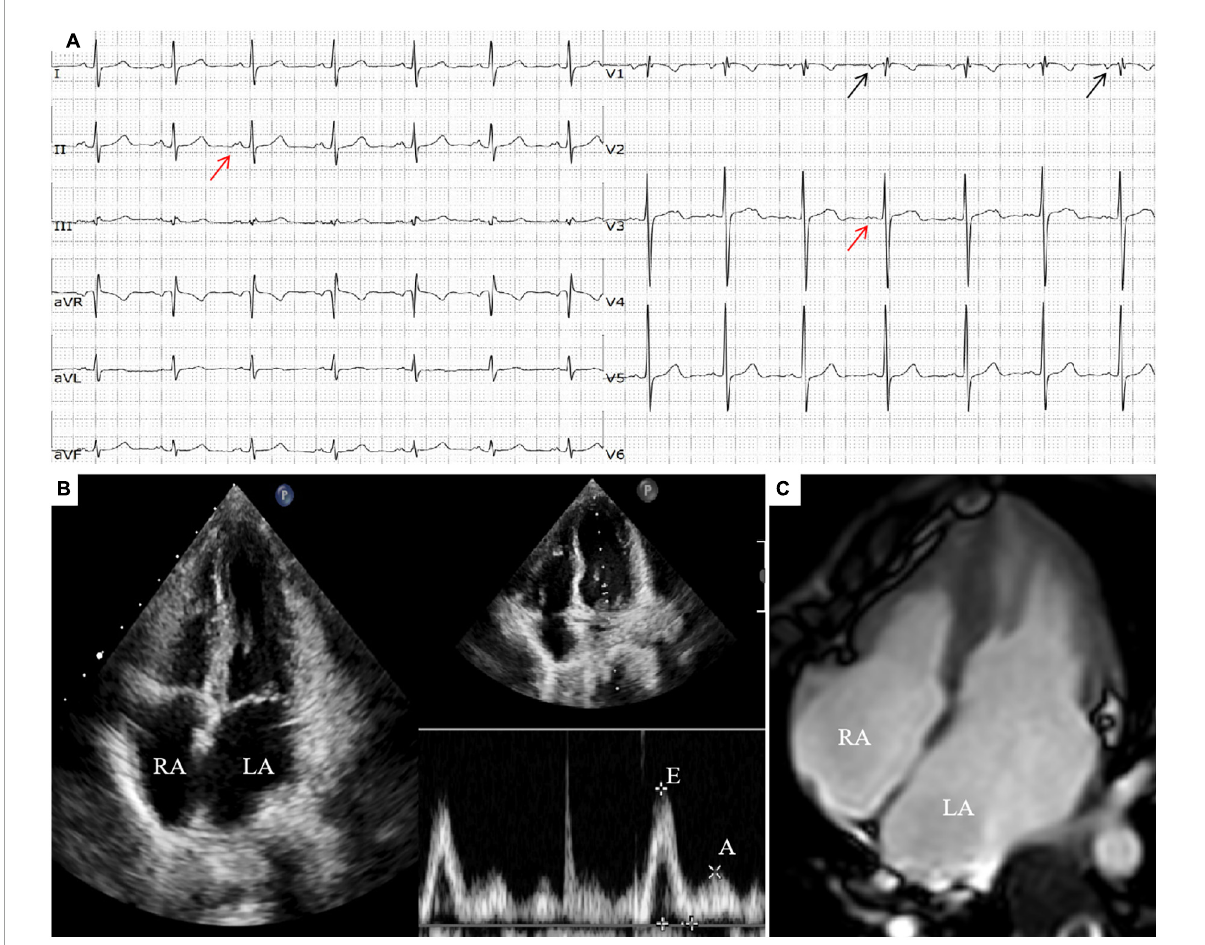
FIGURE1 (A) ECG showed sinus rhythm, incomplete right bundle branch block, Ptf-V 1 < –0.04 mm · s (the black arrow) and biphasic P waves (the red arrow). (B) Echocardiogram showed biatrial enlargement, left atrium obvious (LA: 32 mm, RA: 30 mm) and decreased diastolic